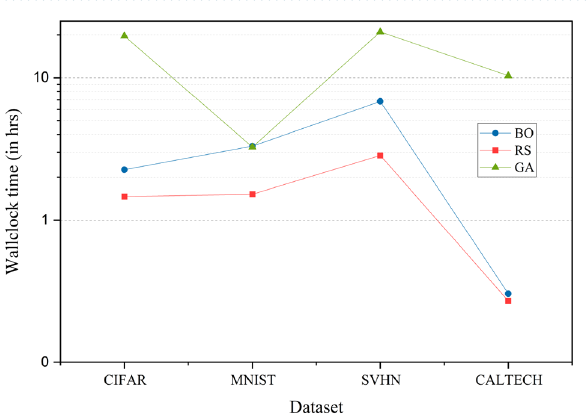
Figure 2. Test set classification error plot of AutoKeras and TPOT. The figure shows the average test error rate across the datasets—CIFAR, MNIST, SVHN and CALTECH. The HPO techniques compared in the graph are BO, RS, Hyperband and GA. AutoKeras is run 3 times—using BO, RS and Hyperband for HPO for each dataset. TPOT is run once for each dataset and it uses GA for HPO.